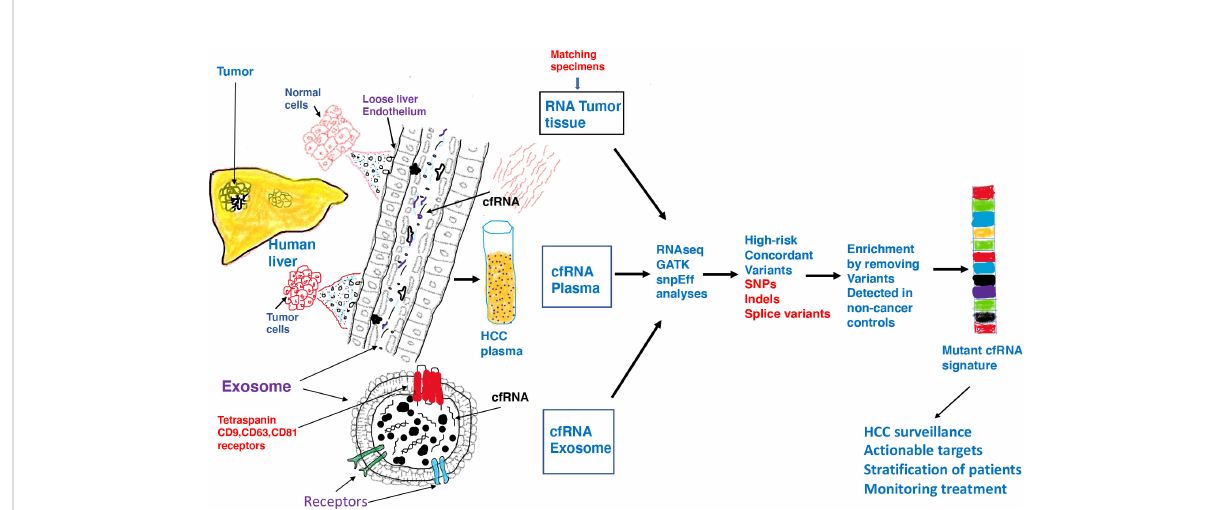
FIGURE 9 In fl ammatory and toxic milieu in the liver in fl uences the tumor microenvironment resulting in release of tumor derived transcripts in the circulation. Malignant tumor cells exhibit pervasive changes in DNA which consequently lead to a variety of changes in gene expression or genomic instability. Both functionally normal and tumor cells in liver communicate with their surroundings through exosomes which are able to enter the loose endothelial vasculature in liver and land in the circulation. In addition to DNA, proteins and lipids, both free fl oating RNA and RNA within exosomes are found in circulation. Exosomes are vesicles of endosomal origin with tetraspanin receptors embedded in the protein lipid bilayer. Exosomes represent safe vehicles to protect nucleic acids and other cargo from degradation in circulation. We investigated RNA from three different samples from HCC/CCA patients by RNAseq, GATK and SNPeff analyses and identi fi ed high-risk RNA variants concordant in all cancer samples but not detected in non-cancer liver cirrhosis patients and normal healthy controls. We speculate that after characterization in a larger patient cohort, a mutant RNA signature can be derived which can be validated and used in HCC surveillance to accurately identify high risk patients and actionable targets and guide in patient